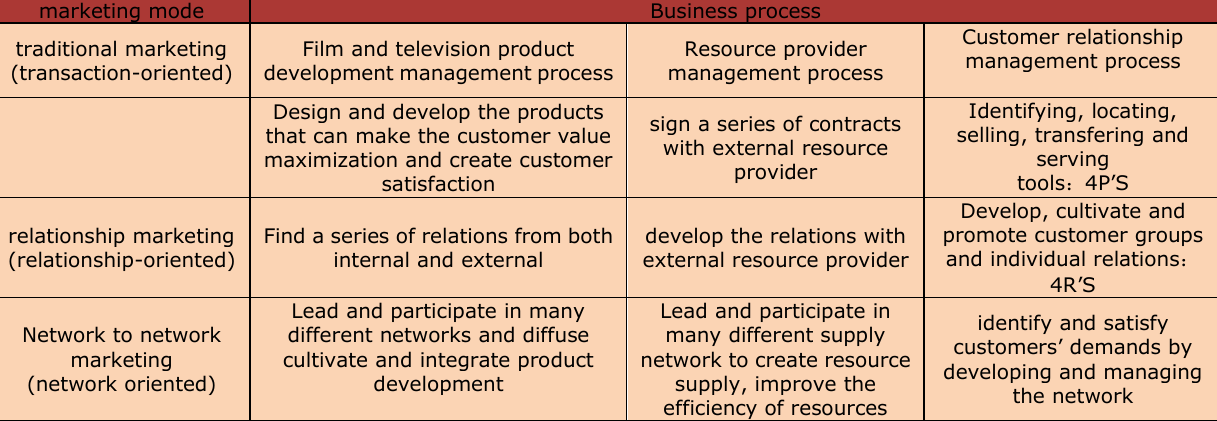
Table 1. Content contrast of three kinds of marketing mode in the main business